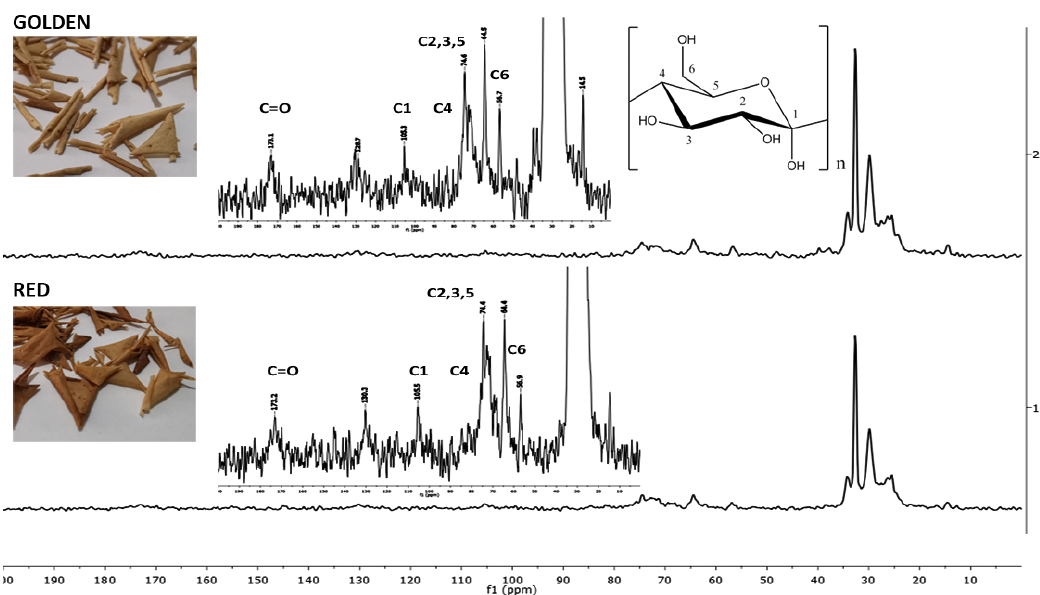
Figure 1. Cross polarization magic angle spinning nuclear magnetic resonance (CPMAS 13 C NMR) spectra of cutins from “golden delicious” and “red delicious” apples. Besides the carbohydrate peaks assigned, epoxylated compounds were detected because of their signals at δ 56 and 64